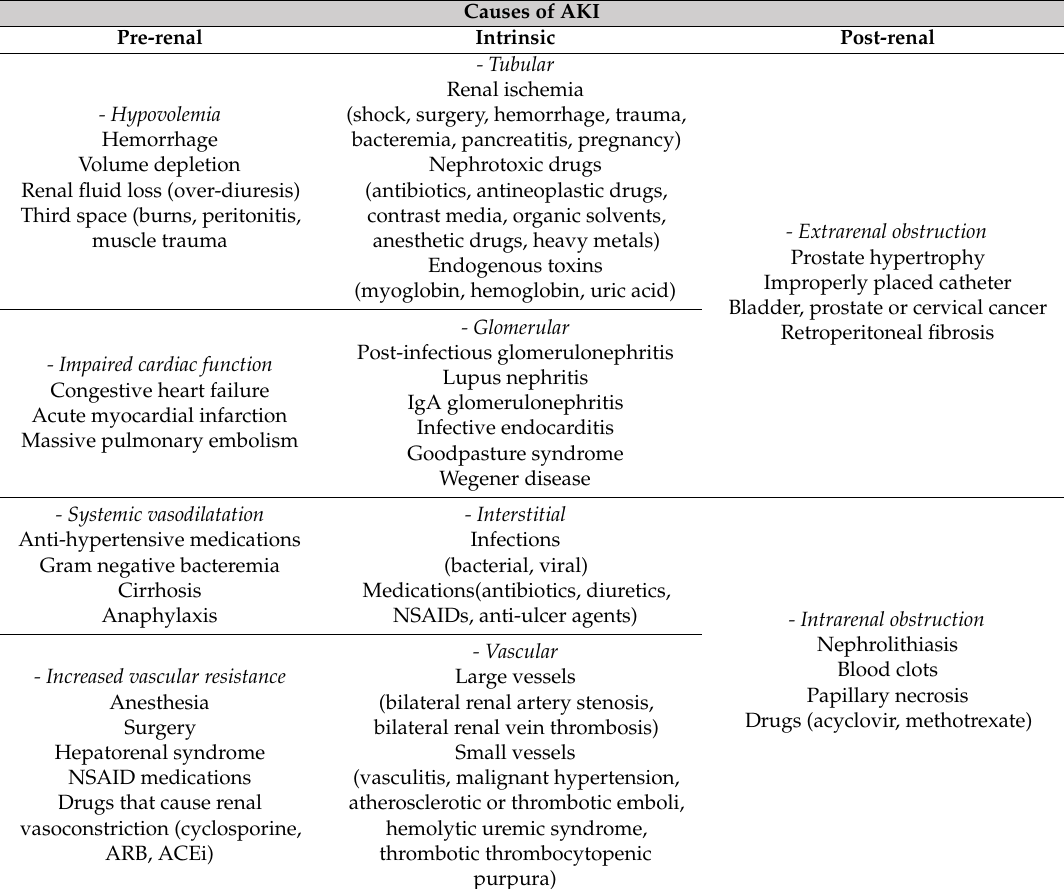
Table 3. Causes of